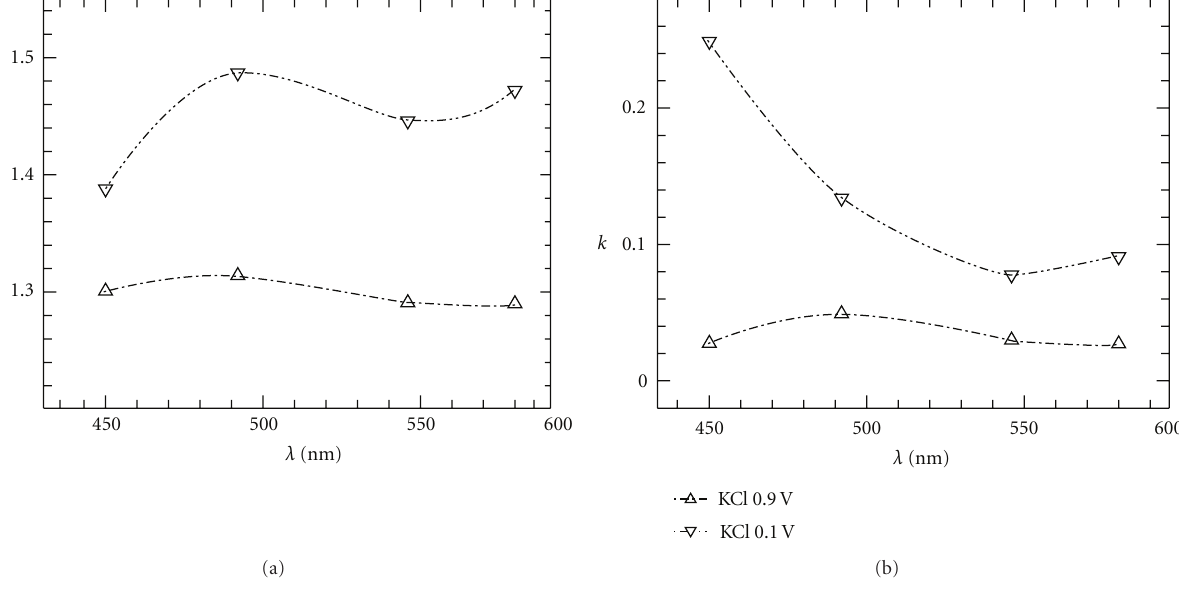
Figure 4: Calculated refractive index n and absorption index k for illuminating light beam in the region 450 < λ < 580, for the film obtained after five cycles with Ea = 1.2 V and τ = 20 s after immersion in